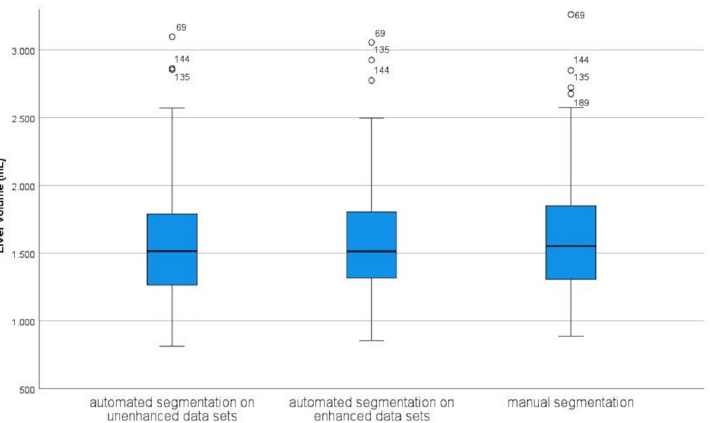
Fig 3. Mean liver volume analysis for thin slice image data